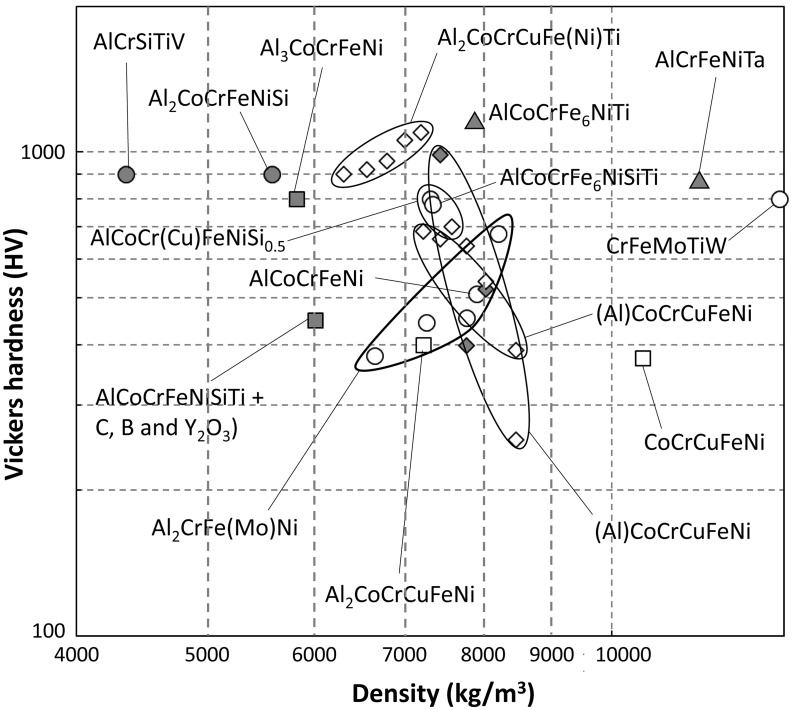
Detailed view of the materials property space for room temperature hardness vs density of laser cladding HEA coatings. Phases present are shown by squares for fcc, circles for bcc, diamonds for duplex (fcc + bcc) and triangles for other phases. SS and (SS + IM) are shown by open and closed symbols, respectively.